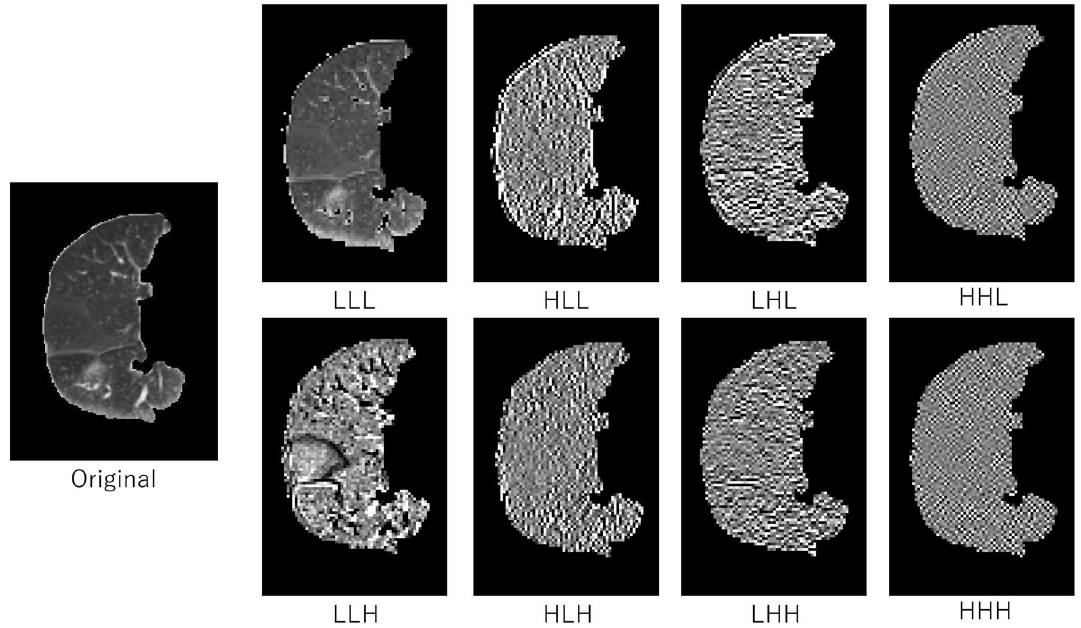
Figure 2. Eight wavelet decomposition images of an original lung volume image by applying either a low-pass filter (scaling function, L) or a high-pass filter (wavelet function, H) in x, y, or z direction, and its corresponding